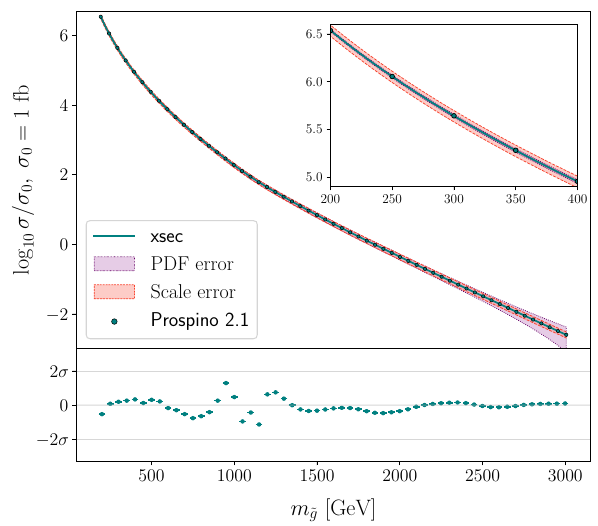
Fig. 2 Gluino pair-production cross-section as a function of gluino mass, with all squark masses fixed at 1TeV. The central value is shown in light green, the scale error in pink, and the PDF error in violet. The α s error is too small to be visible on the scale of the plot. Superimposed on the prediction are the Prospino values (dots). Inset is a close-up of the region at low gluino mass, and below we show the residual between the xsec prediction and the Prospino values